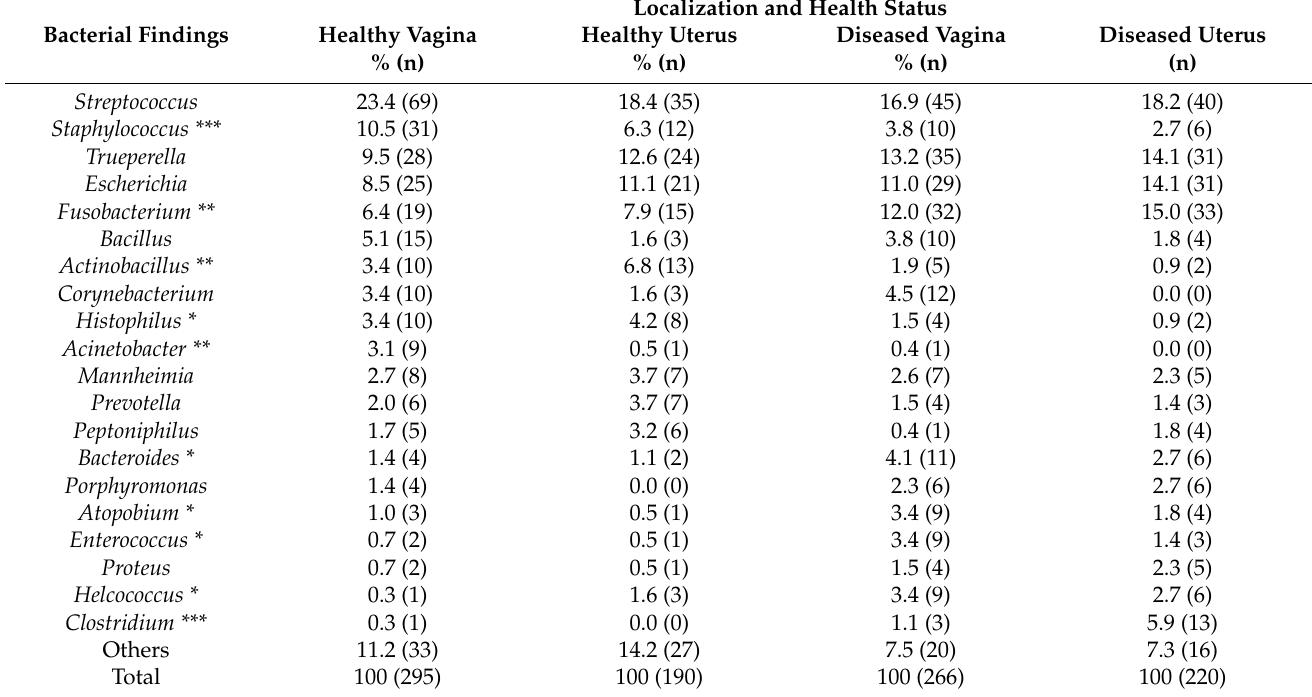
Table 5. Microbial community of the vagina and uterus at genus level of 22 cows within 14 days of calving, cows that remained healthy and cows with puerperal disorders compared. Genera are ordered by